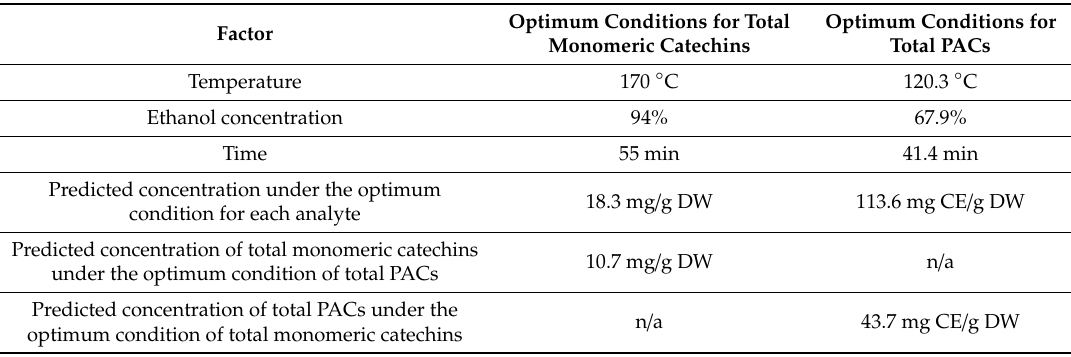
Table 3. Optimum settings of temperature, ethanol concentration, and time that maximized both total were obtained by maximizing each response variable separately.